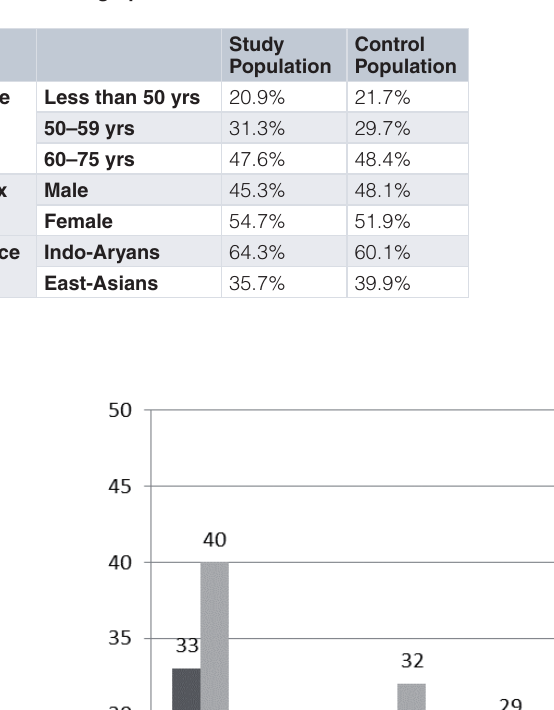
Table 1. Demographic